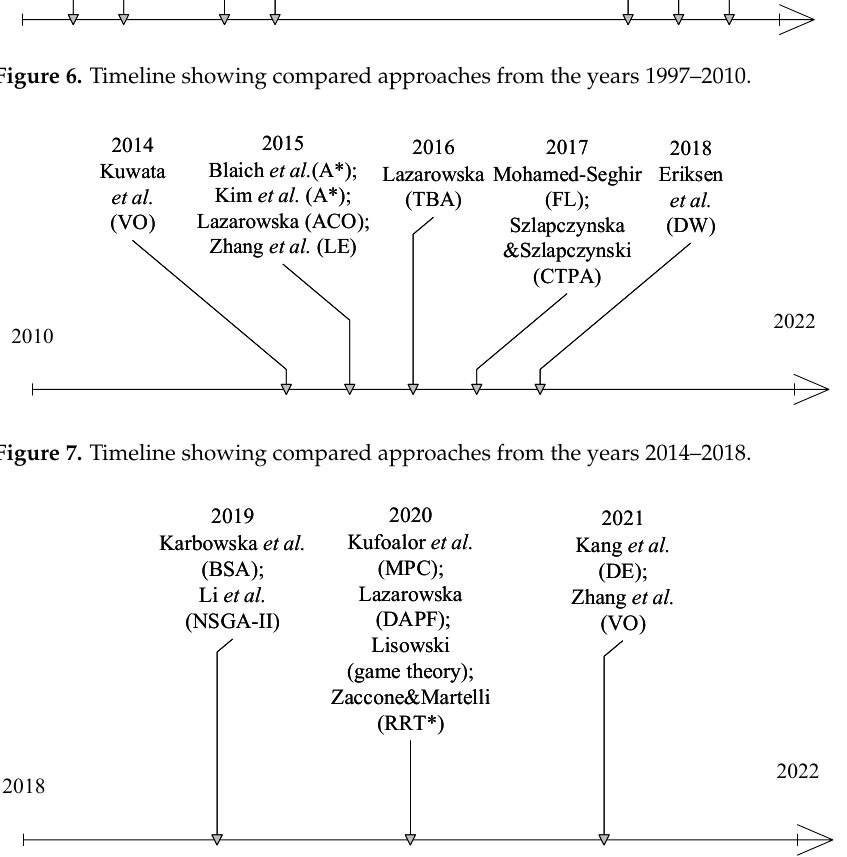
Figure 8. Timeline showing compared approaches from the years